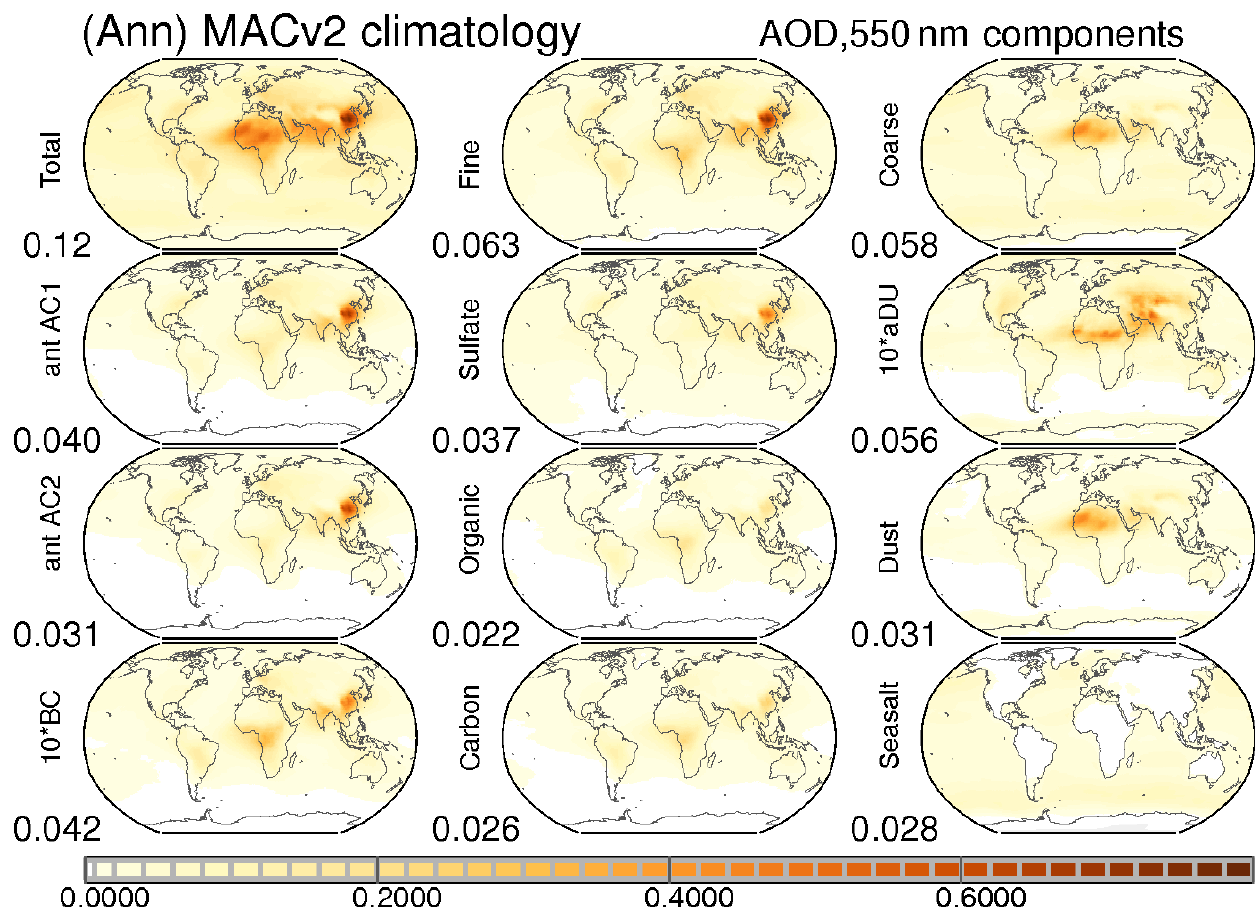
Figure E1. Annual average AOD maps for present-day tropospheric aerosol for total aerosol (top left) and contributions by fine-mode sizes (top center) and coarse-mode sizes (top right). In addition, consistent with midvisible absorption data, component AOD values were assigned for each size mode. Fine-mode AOD is divided into contributions by BC (soot, here multiplied by 10), OC (organic matter) and SU (where SU represents nonabsorbing fine-mode aerosols). The coarse-mode AOD is split into contributions by sea salt and dust. In addition, annual AOD maps are presented for total carbon (OC + BC), for present-day anthropogenic dust (aDU, here multiplied by 10) and estimates for present-day anthropogenic (fine-mode) AOD: ant AC2 of MACv2 and ant AC1 of MACv1. Lower-left values indicate global